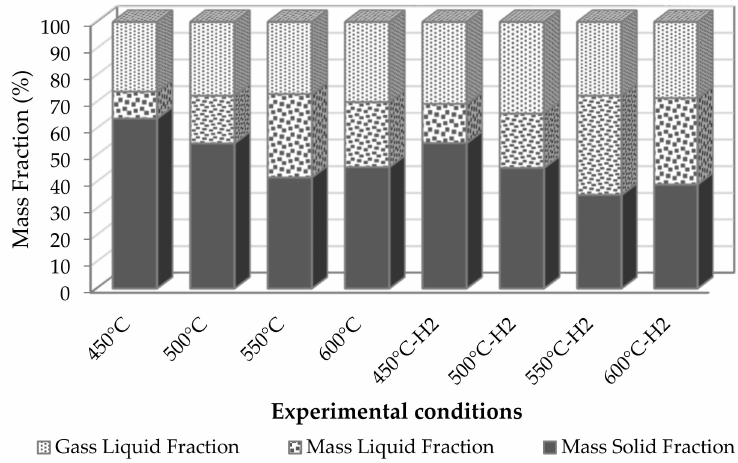
Figure 3. Gas, liquid and solid mass fractions obtained after pyrolysis was